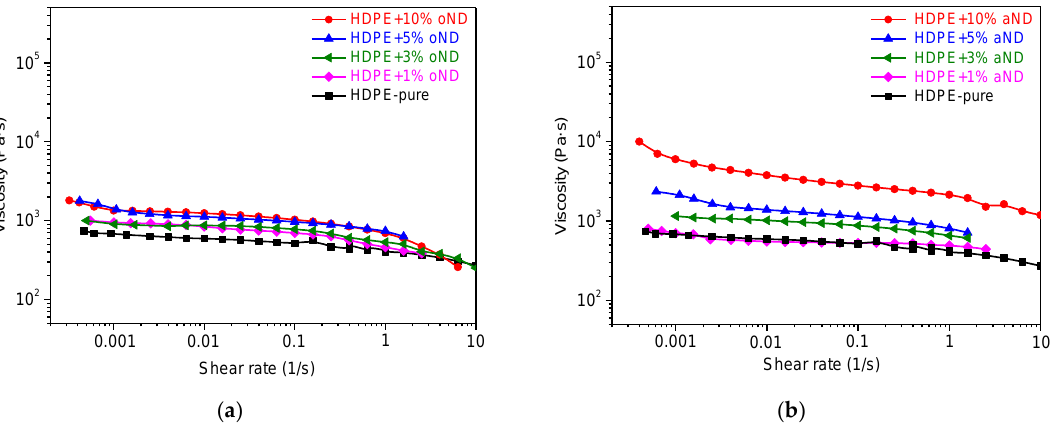
Figure 1. Dependences of the viscosity on the shear rate for the HDPE-based composite melts with the added nanoparticles of oND ( a ) and aND ( b ).